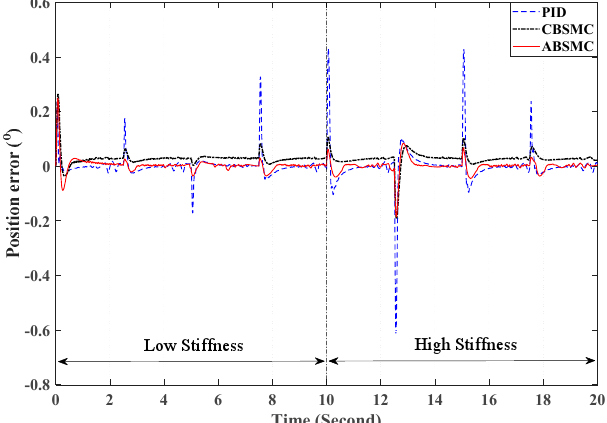
Figure 13. The angular error responses to the multistep reference of the manipulator with the PID control, the CBSMC, and the proposed ABSMC.